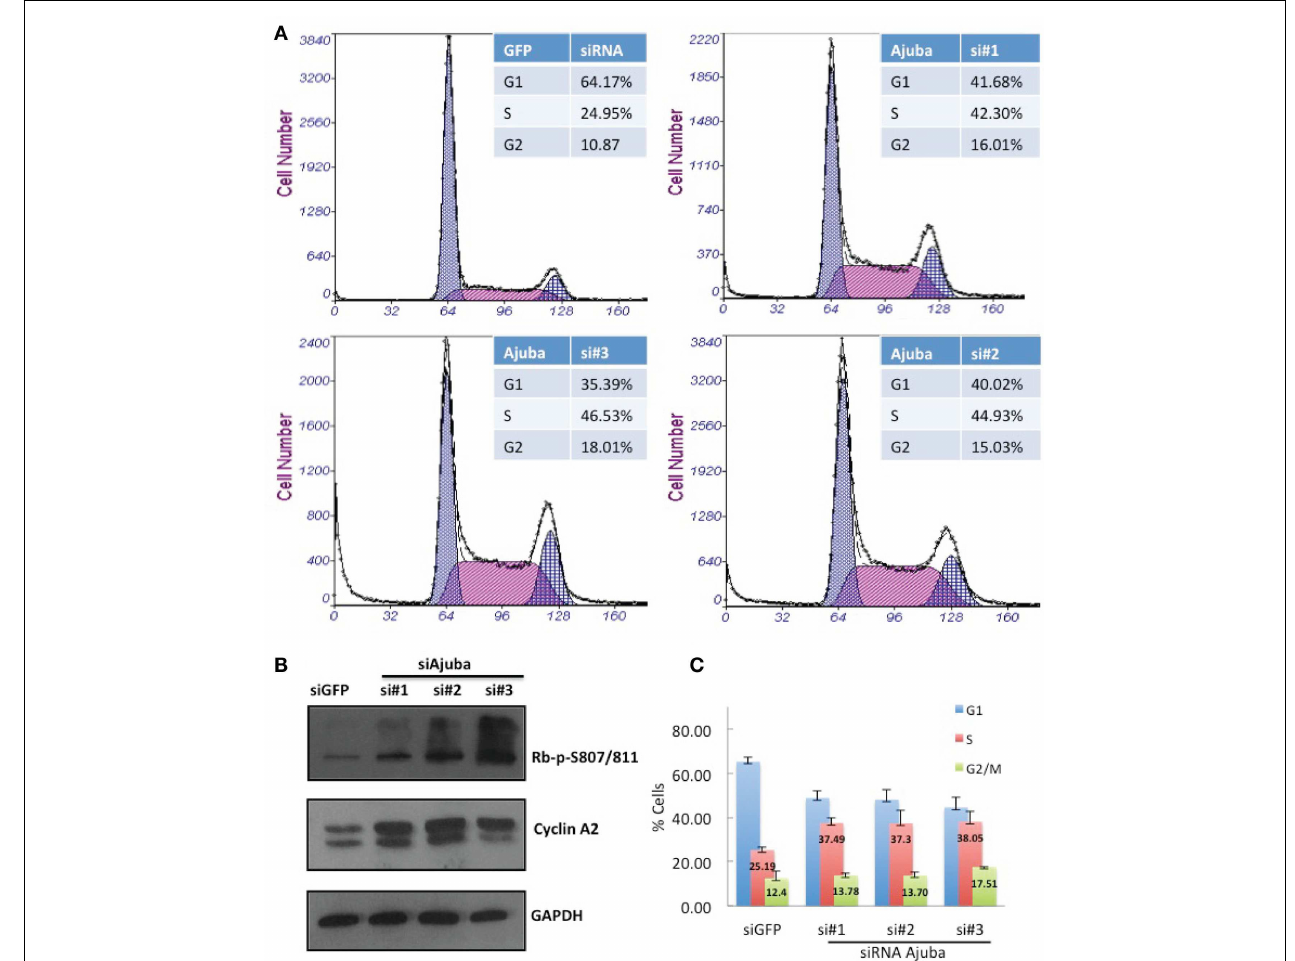
levels of Cyclin A2, with GAPDH as a loading control. (C) Cell cycle profiles of cells processed as in (A) , with% of cells in G1 or G2/M indicated as averages of three independent